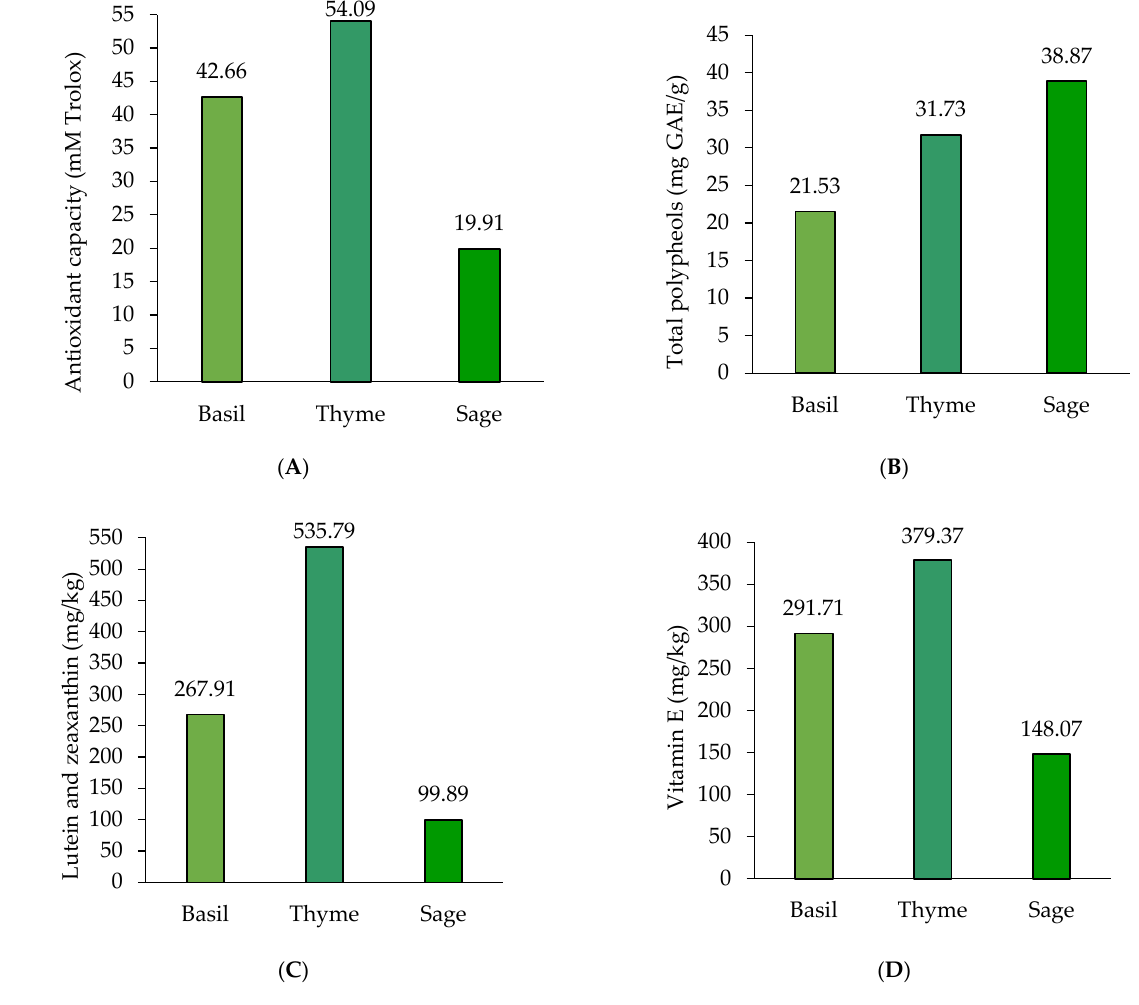
Figure 1. Bioactive compounds with antioxidant activity of plants; ( A ) total antioxidant capacity; ( B ) polyphenol content; ( C ) lutein and zeaxanthin; ( D ) vitamin E content; ( n = 3).